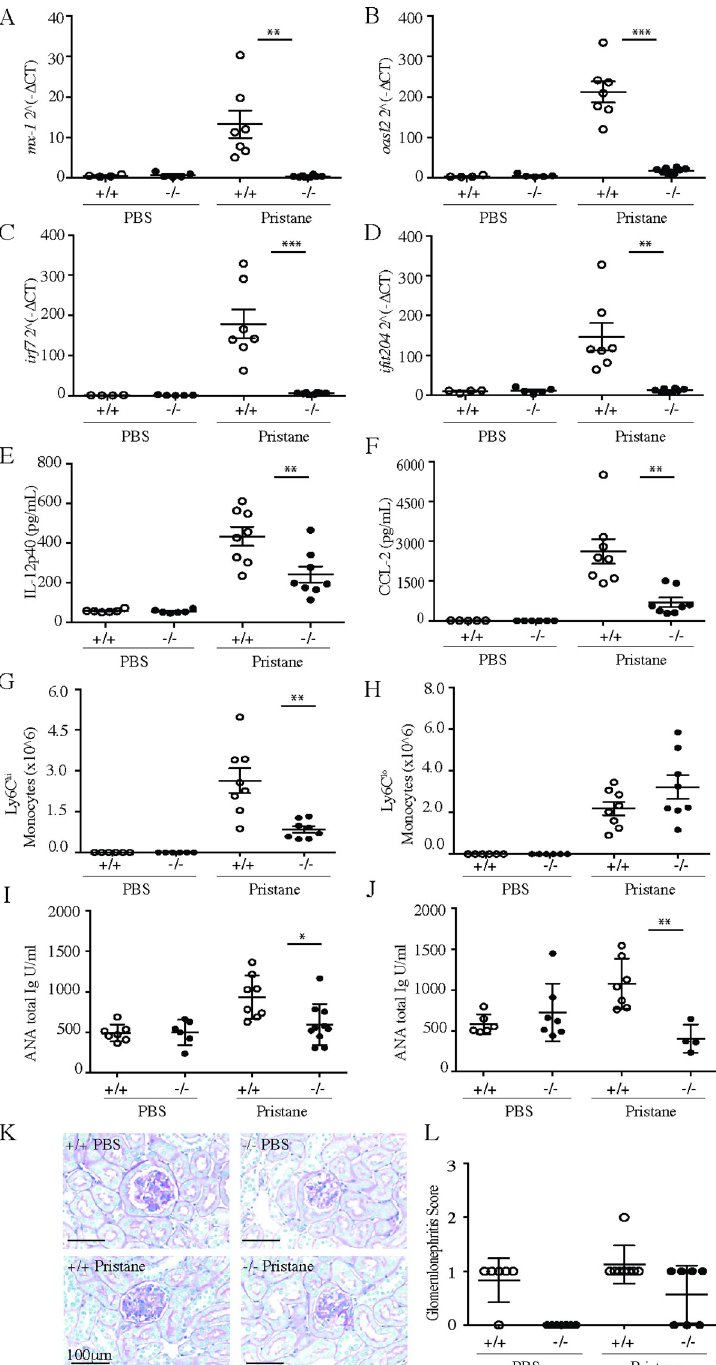
Fig 3. SLC15A4 deficient mice are protected in pristane induced lupus model. Two cohorts of 11-week-old wild- type mice (C57BL/6) and slc15a4 -/- mice (on C57BL/6 background) were injected intraperitoneally with either 500 μ l PBS or pristane. Two weeks post pristane administration, peritoneal lavage was collected from cohort 1, and expression of Interferon signature genes (A-D), secretion of IL12p40 (E) and CCL-2 (F), and number of inflammatory Ly6Chi monocytes (G-H) were assessed by qRT-PCR, Luminex and flow cytometry, respectively. In cohort 2, serum concentrations of anti-nuclear antibodies were assessed 4 months (I) and 9 months (J) after pristane administration. Renal glomerulonephritis was assessed by histological assessment of H&E stained sections after 9 months of pristane administration (K) and scored as described in the methods section (L), and plotted with group means ± SD. � p < 0.05, �� p < 0.005, ��� p < 0.0005, N = 7 animals per group (some mice had to be euthanized during study due to fight injuries). https://doi.org/10.1371/journal.pone.0244439.g003 PLOS ONE | https://doi.org/10.1371/journal.pone.0244439 January 14,